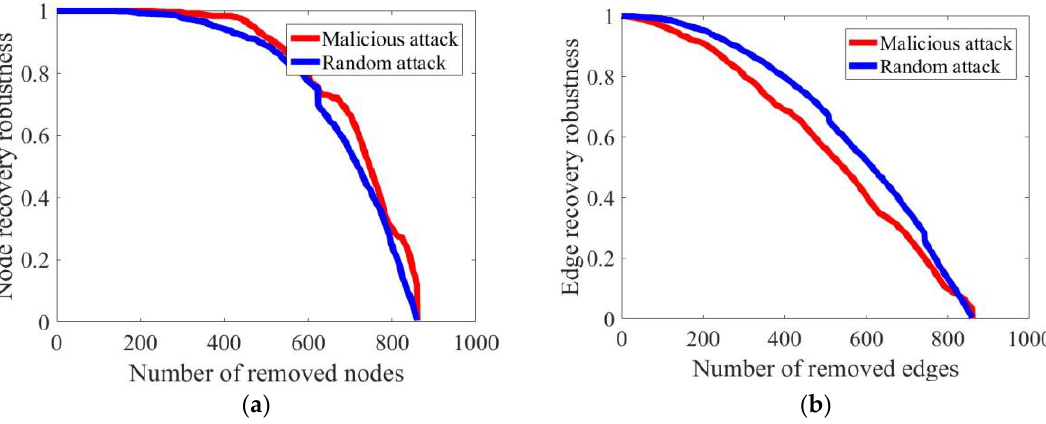
Figure 12. ( a ) Node recovery robustness; ( b ) corridor recovery robustness.